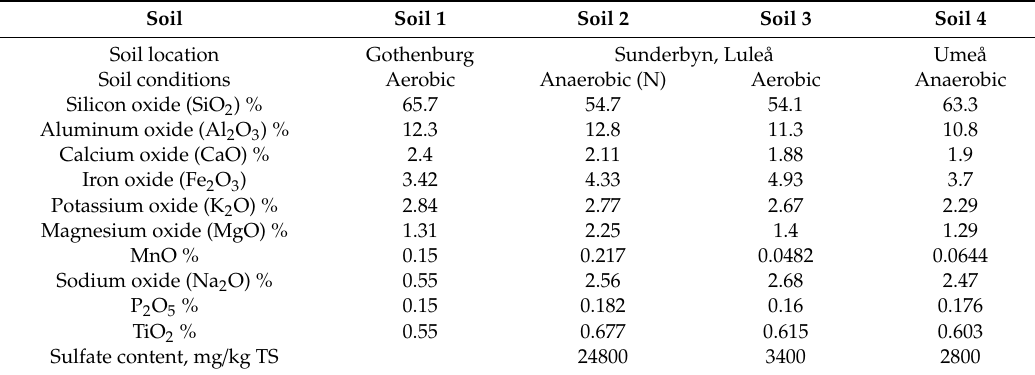
Table 3. Chemical composition of tested soils.